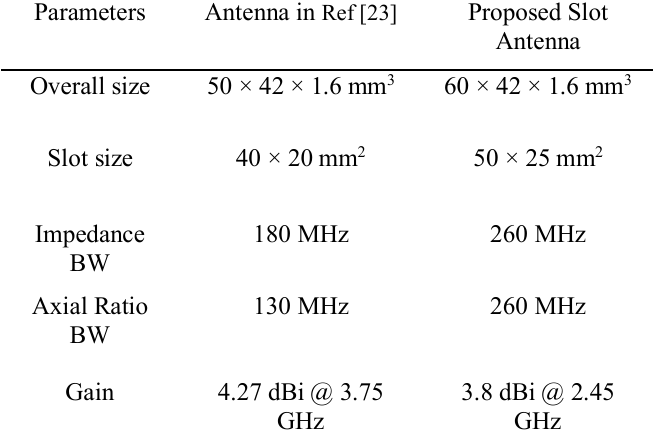
Table 1: Comparison between proposed slot antenna and the antenna in Ref